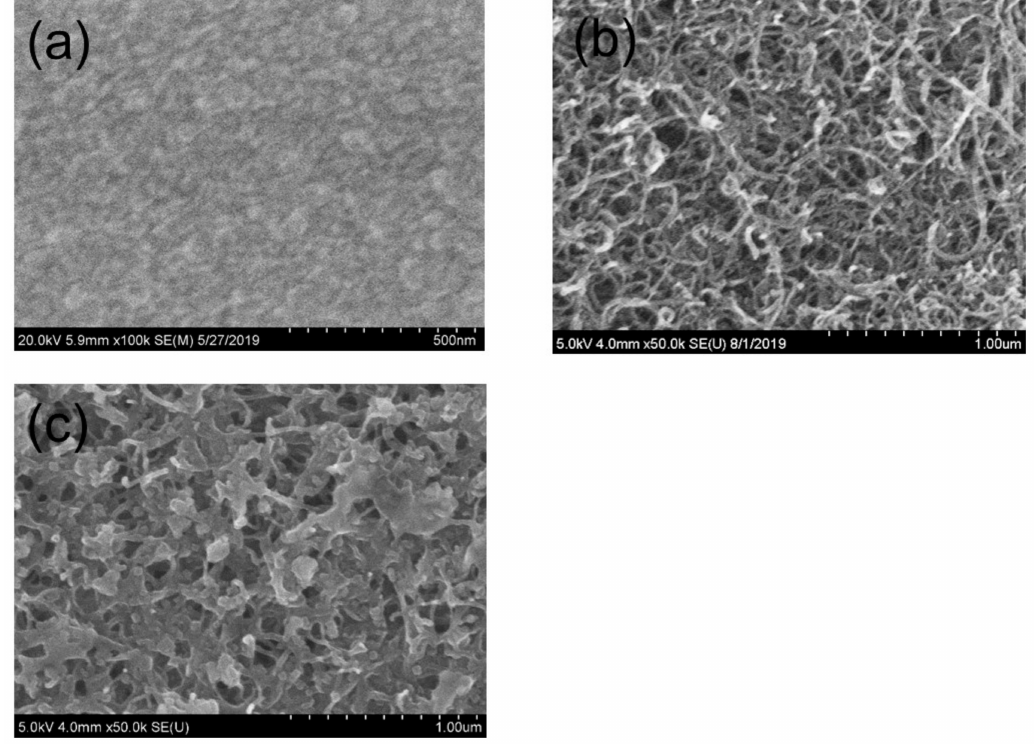
Figure 1. SEM images of ( a ) bare ITO, ( b ) fMWCNT/ITO and ( c ) pyrrole@sol-gel